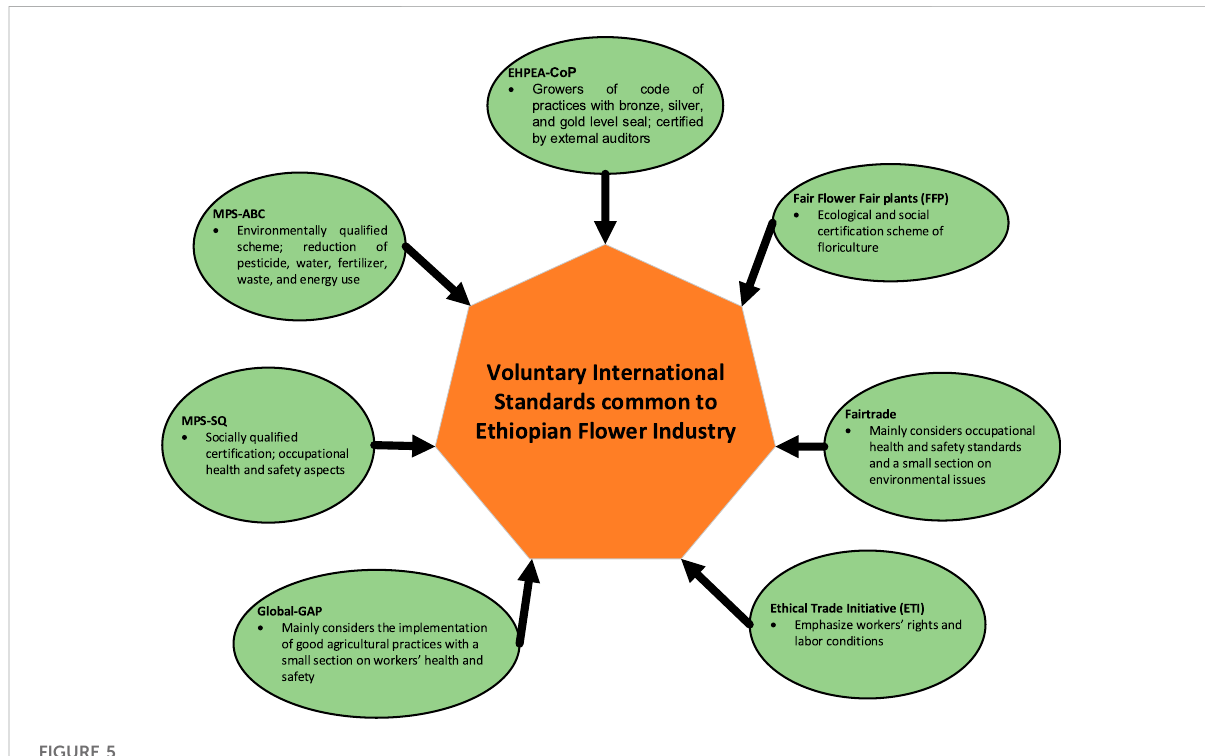
FIGURE 5 Common social and environmental standards in the Ethiopian fl ower industry. Rikken, 2010; Mengistie et al.,